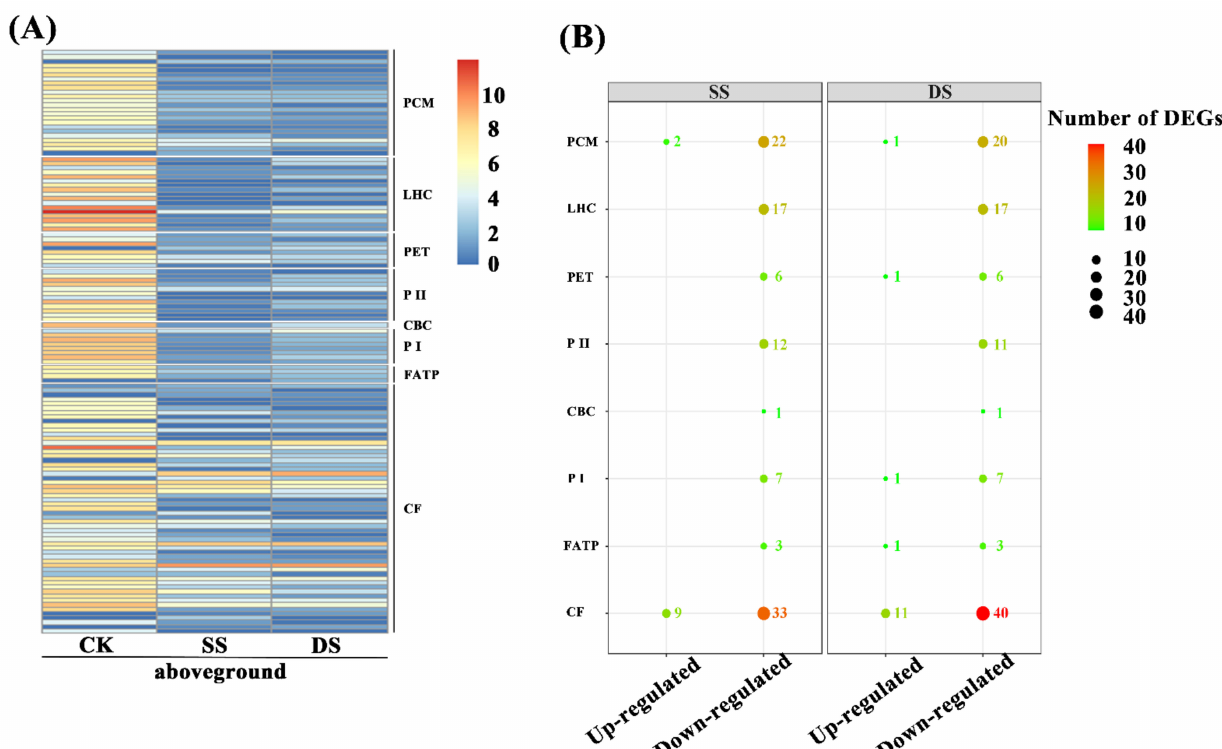
Figure 2. The expression of differentially expressed genes (DEGs) related to photosynthesis in aboveground tissues of bermudagrass. ( A ) Heatmap of DEGs expression profiles under control (CK), shallow submergence (SS), and deep submergence (DS). The x axis represents different treatments. The y axis represents the value of relative expression level (log 2 (FPKM + 1)). ( B ) The number of DEGs expression under SS and DS. Point size correlates with the number of DEGs. FPKM: fragments per kilobase of transcript per million mapped reads; PCM: porphyrin and chlorophyll metabolism; LHC: light-harvesting chlorophyll protein complex; PET: photosynthethic electron transport; P II: photosystem II; CBC: cytochrome b6/f complex; P I: photosystem I; FATP: F-type ATPase; CF: carbon